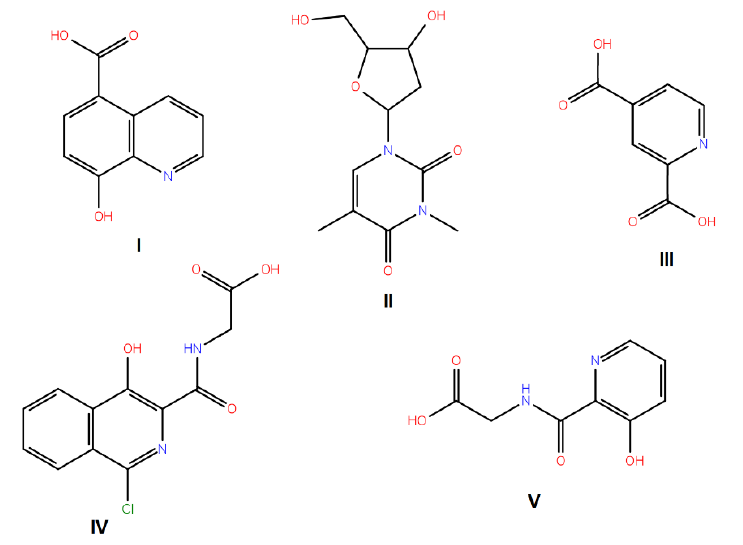
Figure 2. A set of the known FTO inhibitors used as templates in high-throughput virtual docking screening.